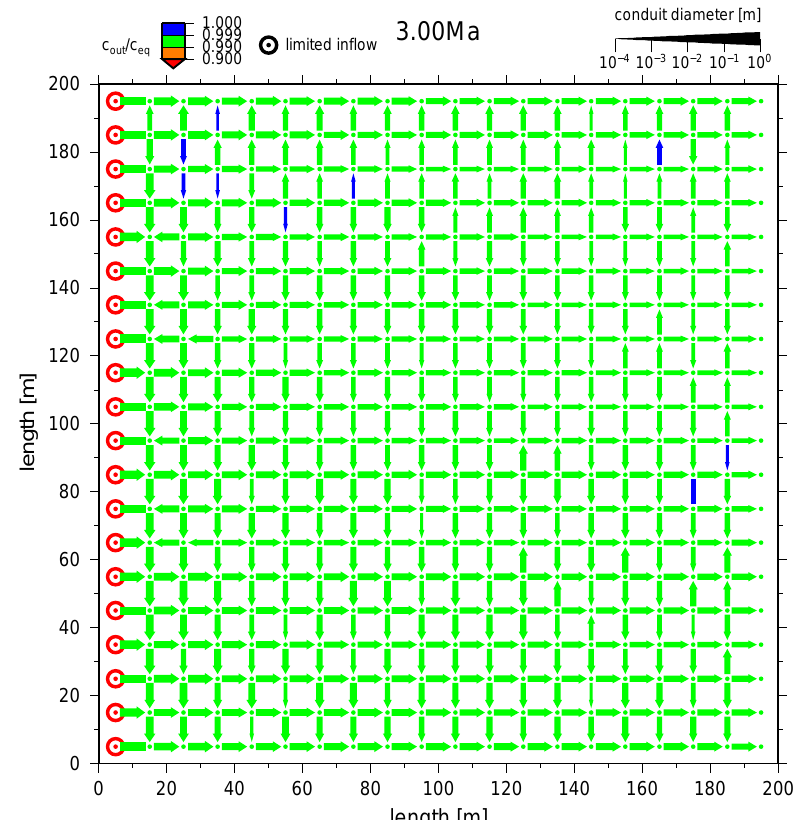
Fig. 9. Example of conduit pattern showing the same realisation illustrated in Fig. 2 but for the long-term simulation of suppressed flow scenarios with Q max = 10 − 8 m 3 s − 1 and low initial aperture